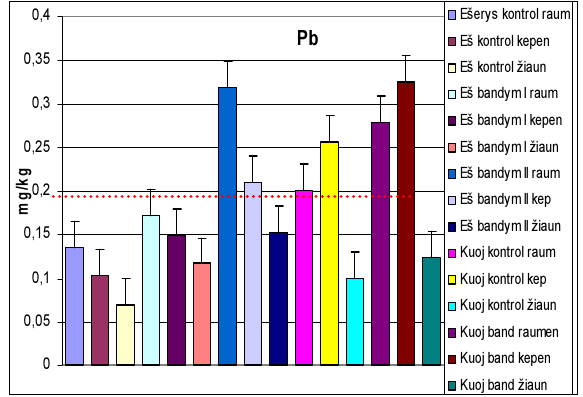
Fig. 11. Heavy metal concentrations (mg/kg) in fish tissu- es from water contaminated with plumbum in 2005